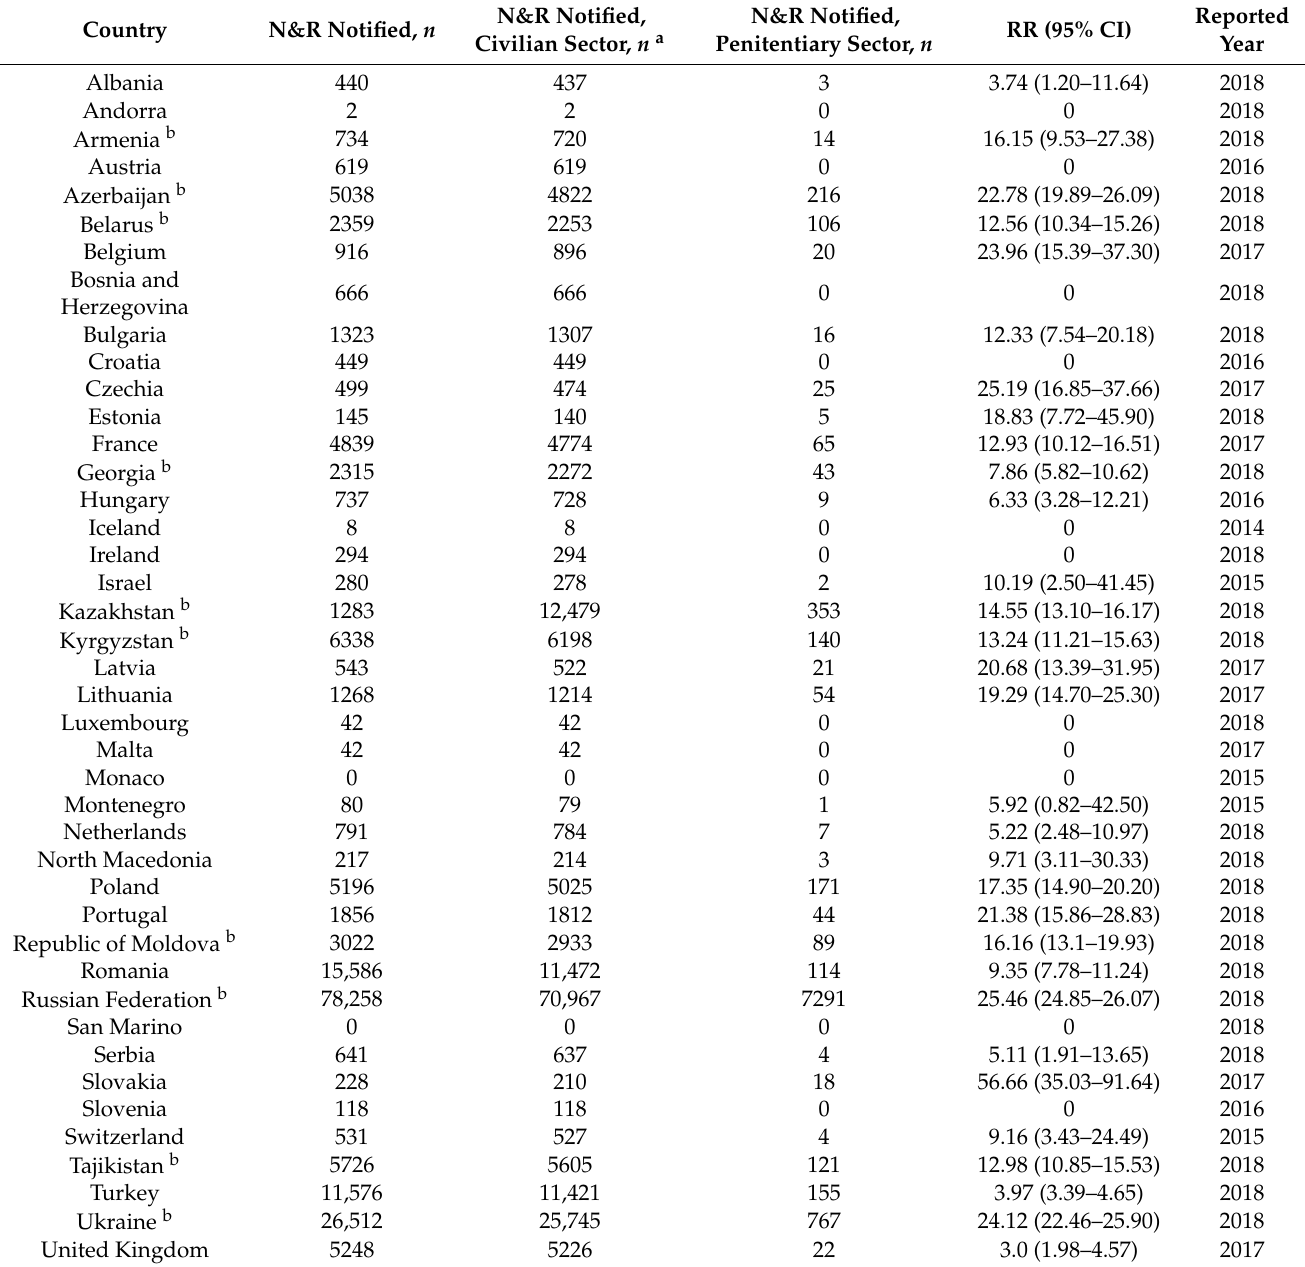
Table 3. Notifications of new and relapse TB cases in the civilian and penitentiary sectors and relative risks (RR) of developing TB for inmates in relation to the civilian population, WHO European Region,